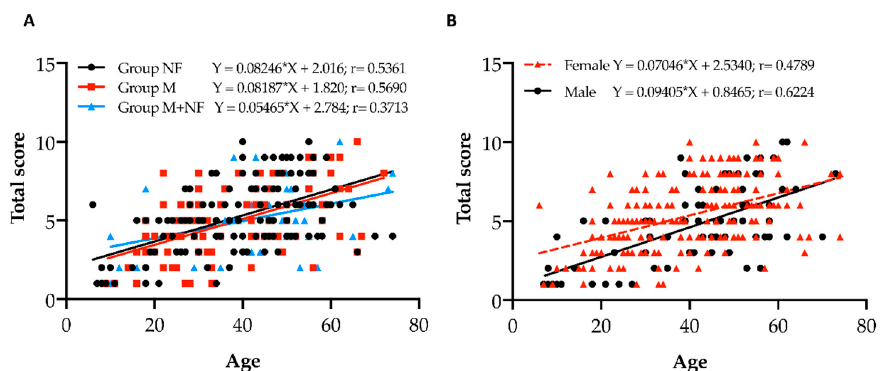
Figure 3. The severity of clinical manifestations, evaluated as total score measured at the time of molecular diagnosis, is significantly dependent on age, with it being higher in aging patients; however, it was not related to either type of variant ( A ) nor to gender ( B ). Group M = two missense variants; group NF = two sequence variants causing reduced protein production or a protein to be likely non-functional; group M + NF = one missense and one “NF” variant.